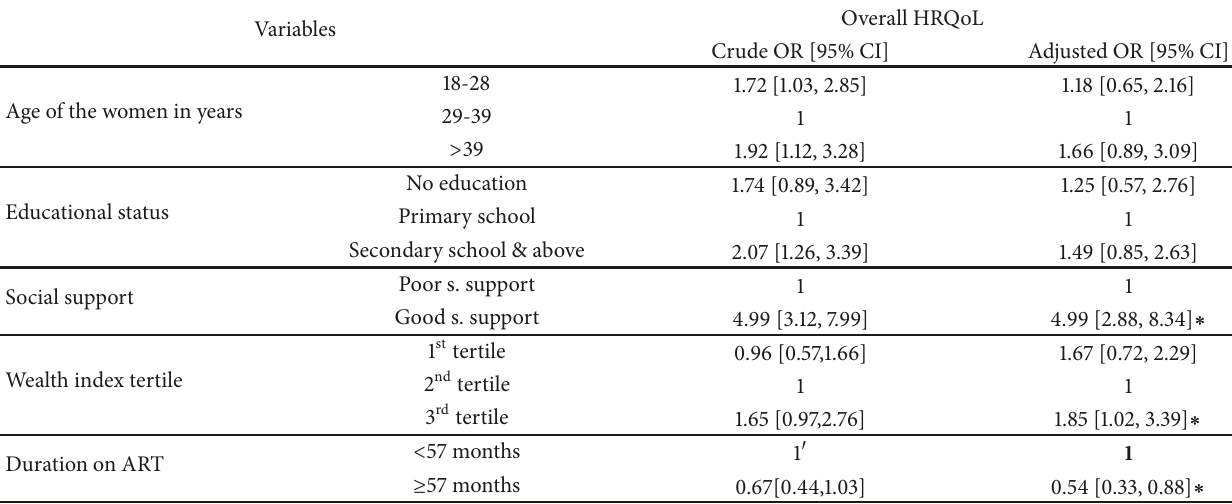
QoL Domains (No. of items)